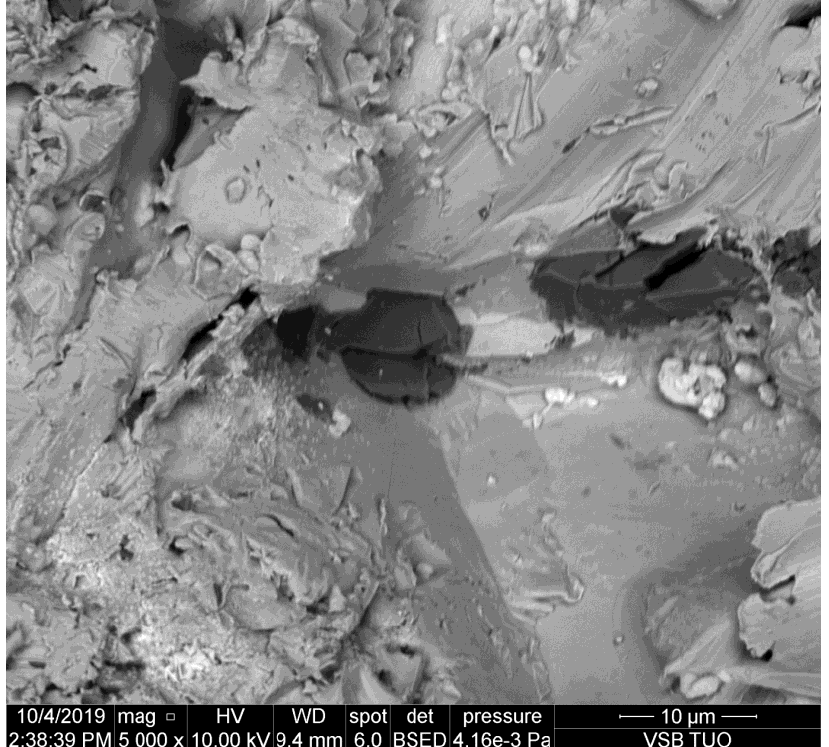
Figure 3. Abrasive particles observed on the sidewall of the kerf made in brass.